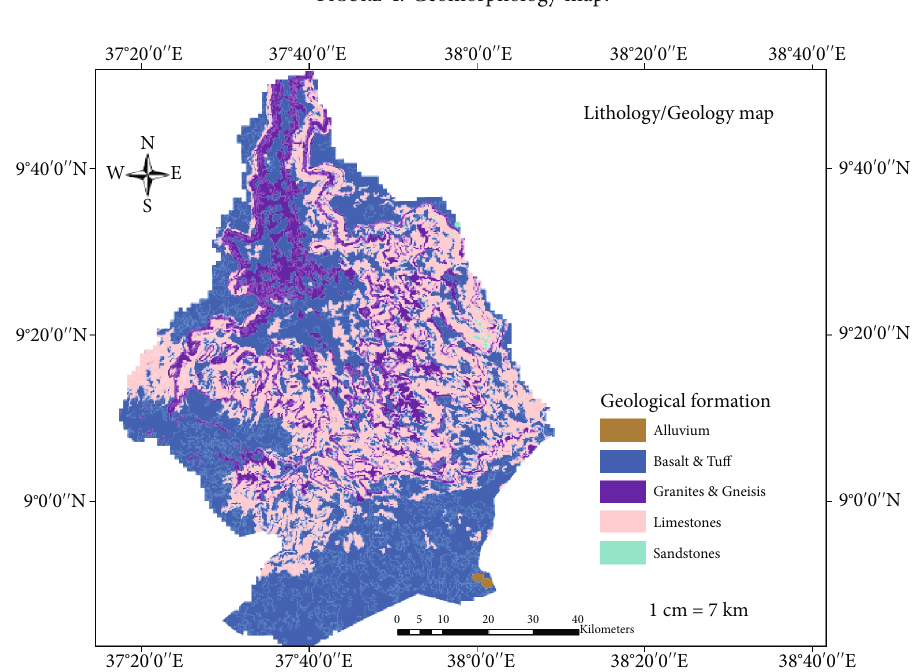
Figure 4: Geomorphology map.